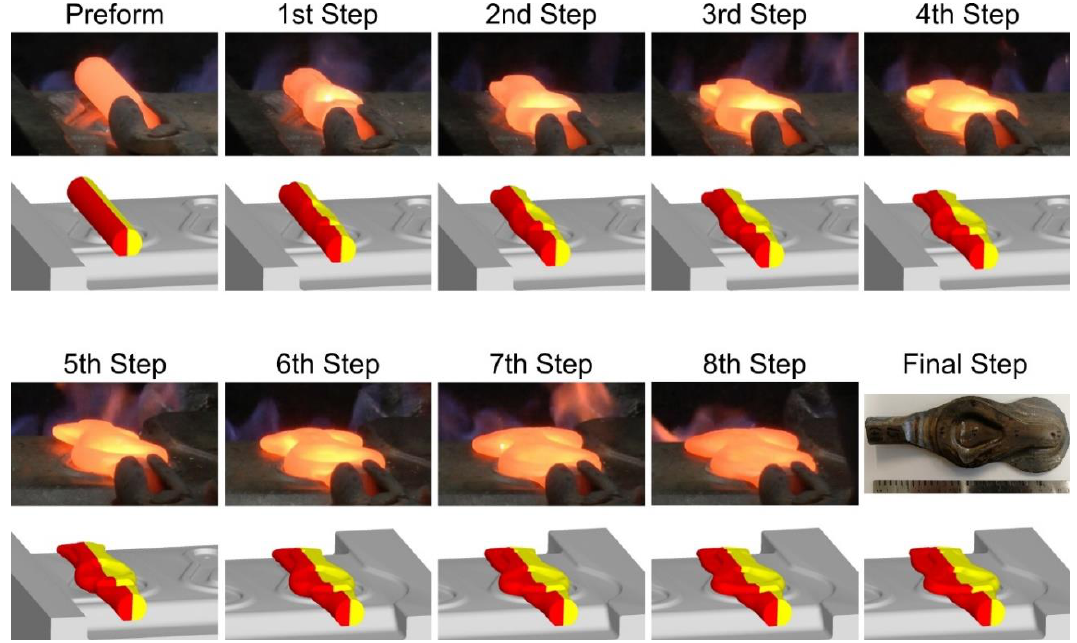
Figure 12. FE model and corresponding photographs of the eye-bolt 2 (Ti-5553 with Ti-6-4) shape evolution after each forging step.